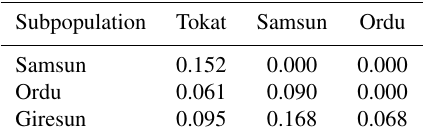
Table 5. Pairwise F ST values among